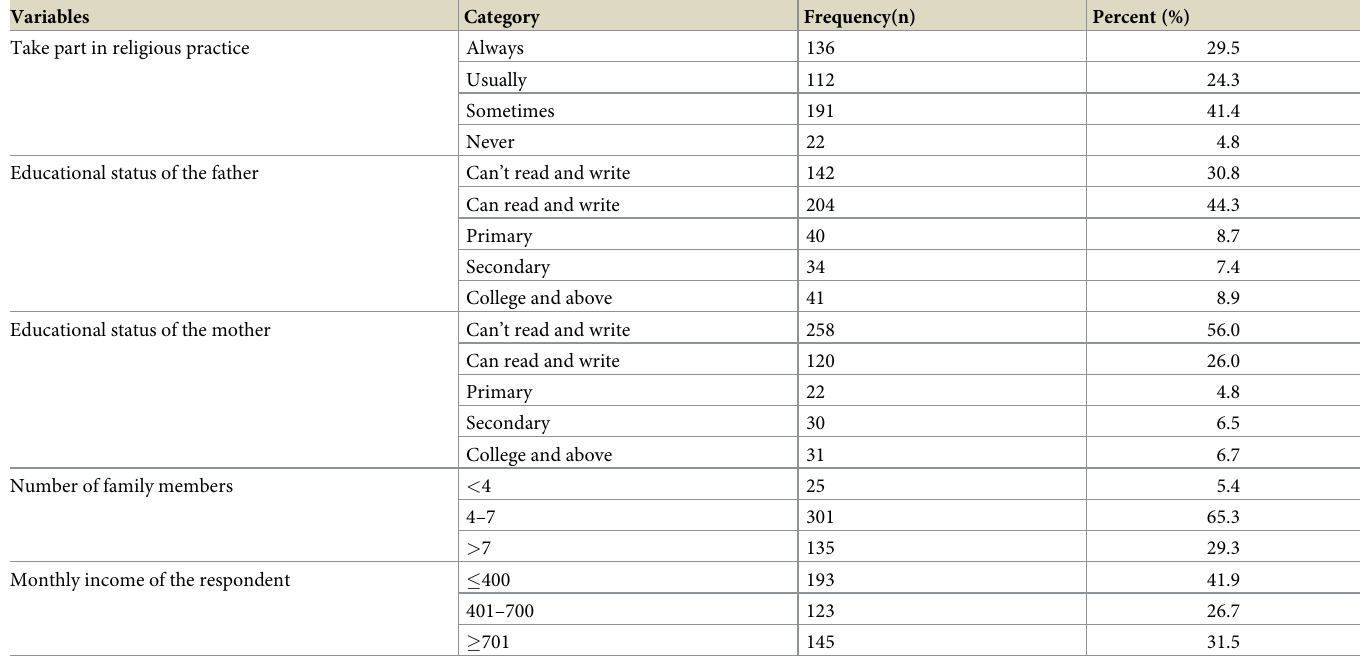
Table 1. Socio demographic characteristics of DMU SMCHS students on mental distress, 2021 (N =